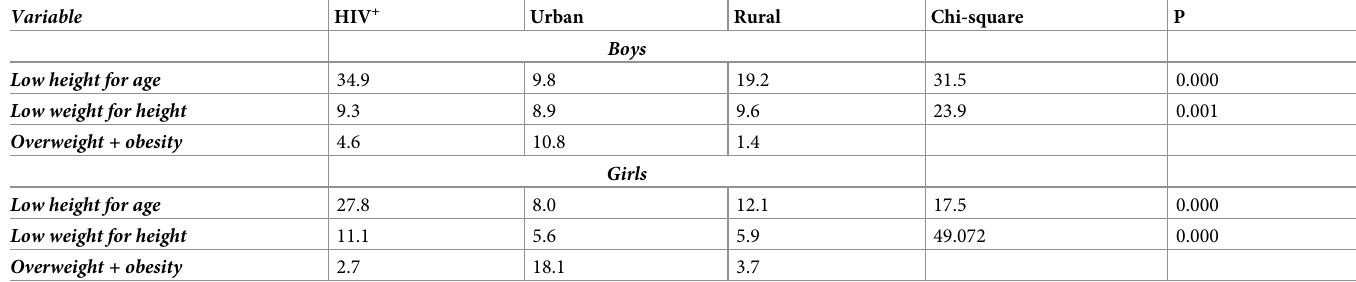
Table 2. Proportion (%) of stunting (low height for age), wasting (low weight for height) and overweight and obesity between HIV + and non-HIV + urban and rural Mozambican boys and girls from the Chi-square test.